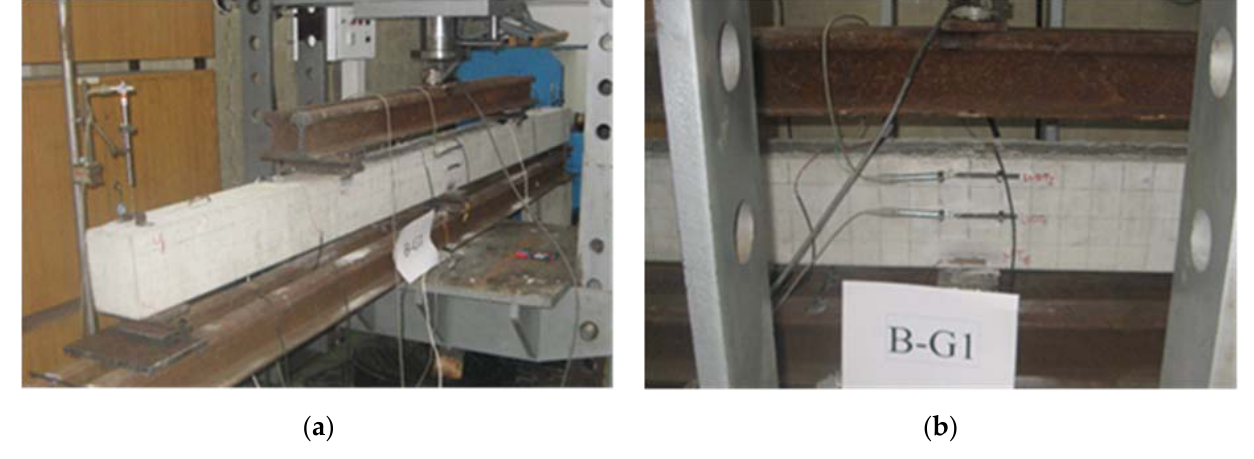
Figure 7. ( a ) Deflectometer U 1 (LVDT); ( b ) Dilatometer positions. Measurement of strains in steel and FRP reinforcement, as well as on the top compressed surface of concrete, was performed with strain gauges—SG. Strain gauges with an electrical resistance of 120 Ω were used, with a base length of 6 mm on steel and FRP reinforcement, and 50 mm on concrete (Figure 8). The gluing of the measuring tapes was done with a special glue, whereby the strain gauges mounted on the steel and FRP reinforcement were additionally protected, since they were installed in concrete or epoxy glue. The position of strain gauges tapes and LVDT dilatometer in Sections I, II and II is presented in Table 7. measuring range up to 100 kN, accuracy 0.5%.